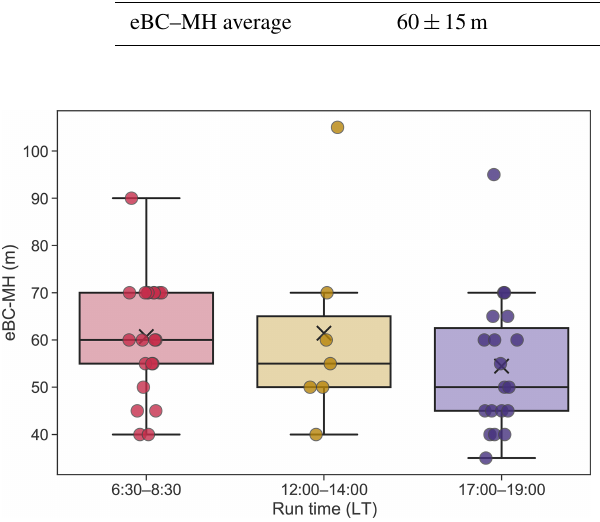
Figure 7. Mixing height (MH) during morning (06:30–08:30LT), afternoon (12:00–14:00LT), and evening (17:00–19:00LT) runs with temperature inversion. Statistics for every run time in a day are represented by a boxplot (cross: mean, horizontal line: median, box: 25th–75th percentile, whiskers: 5th–95th